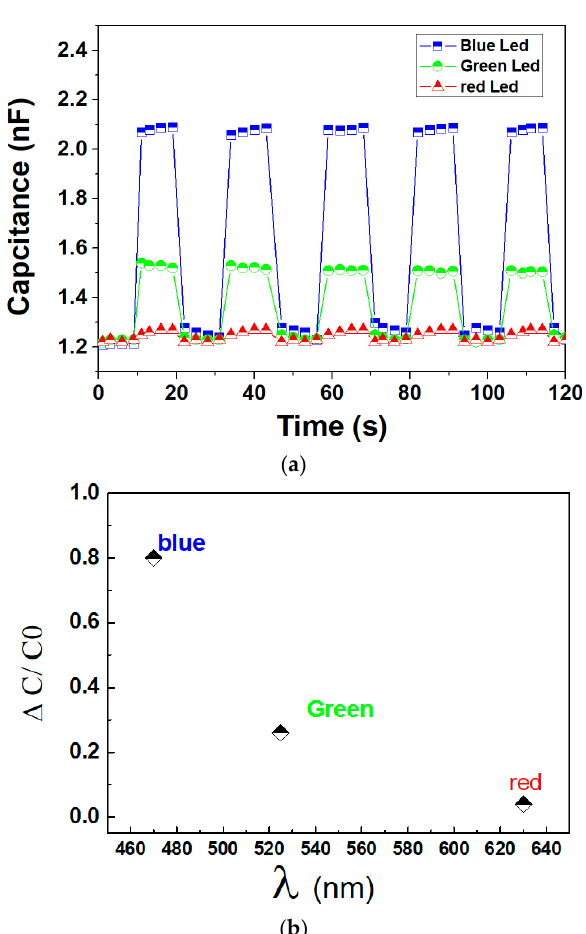
Figure 4. ( a ) Capacitance of polymer composite excited by blue and green lights with on/off cycles. ( b ) Capacitance change ( Δ C /C 0 ) under different wavelength exposure, where Δ C = C − C 0 ; C and C 0 are, respectively, the capacitance value of the composite with and without light application.